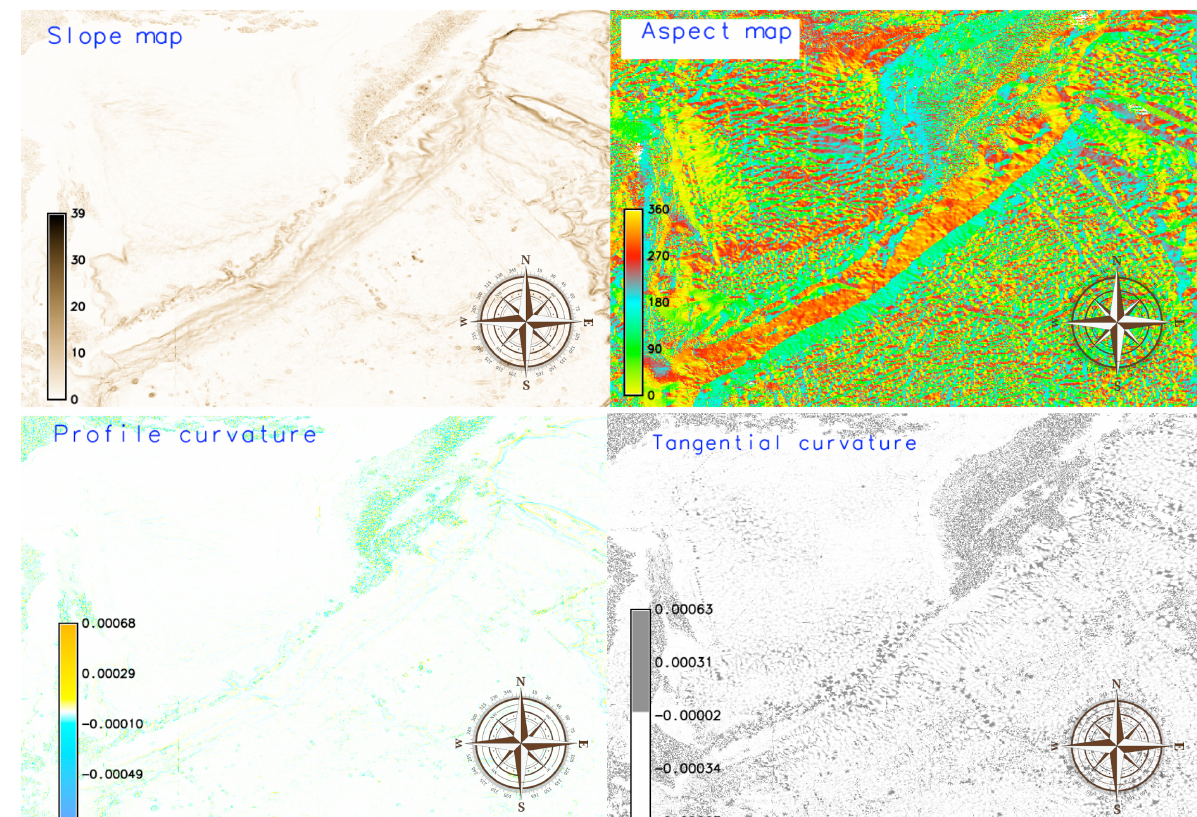
Figure 6. Slope, aspect, profile, and tangential curvature maps, Kuril–Kamchatka region, based on raster grid ETOPO1. Source: